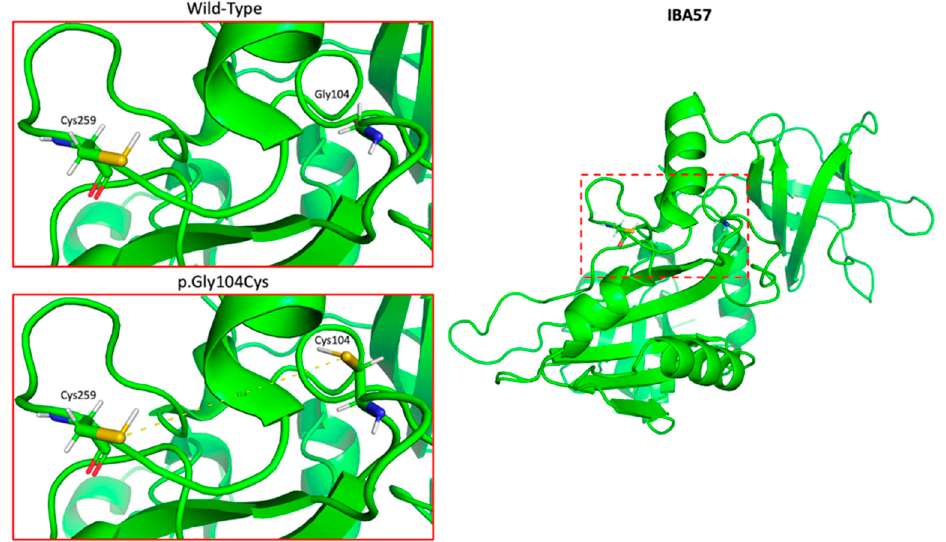
Figure 1. PyMOL model of the crystal structure of IBA57 (RCSB protein databank entry #: 6QE3) showing ~11 Å proximity to the key active Cys259 ligand required for [2Fe-2S] coordination in the context of [2Fe-2S] ISCA2-IBA57 heterocomplex formation.